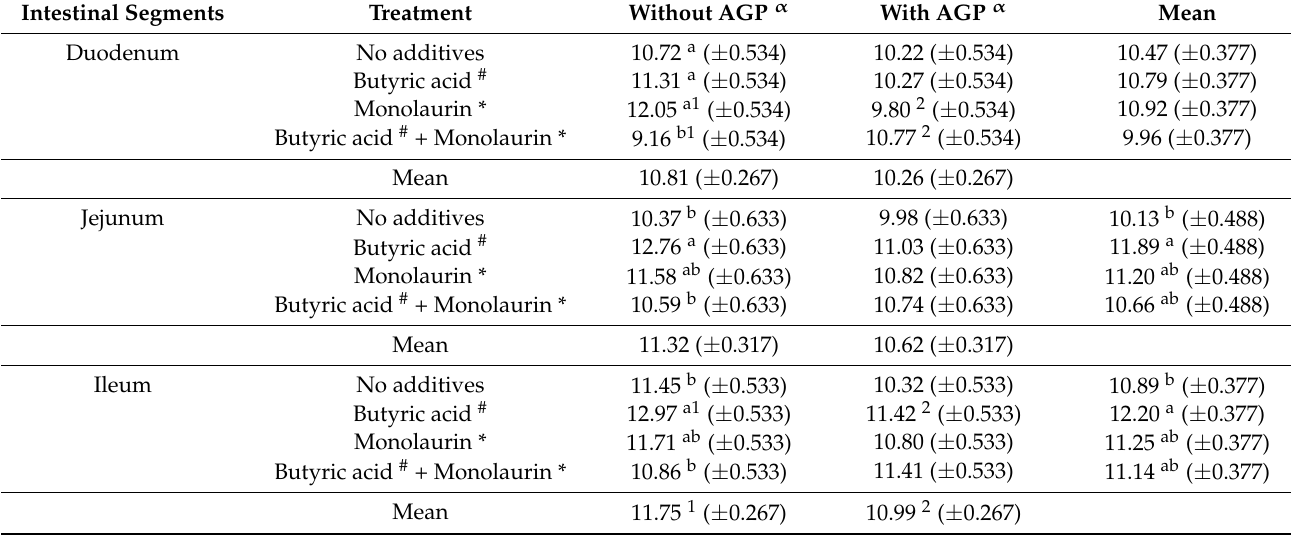
Table 10. The effect of butyric acid and α -monolaurin, with and without the inclusion of an antibiotic growth promoters, on the number of goblet cells per 100 µ m of villi in the duodenum, jejunum and ileum of broilers at 33 days of age ( ± standard error of the